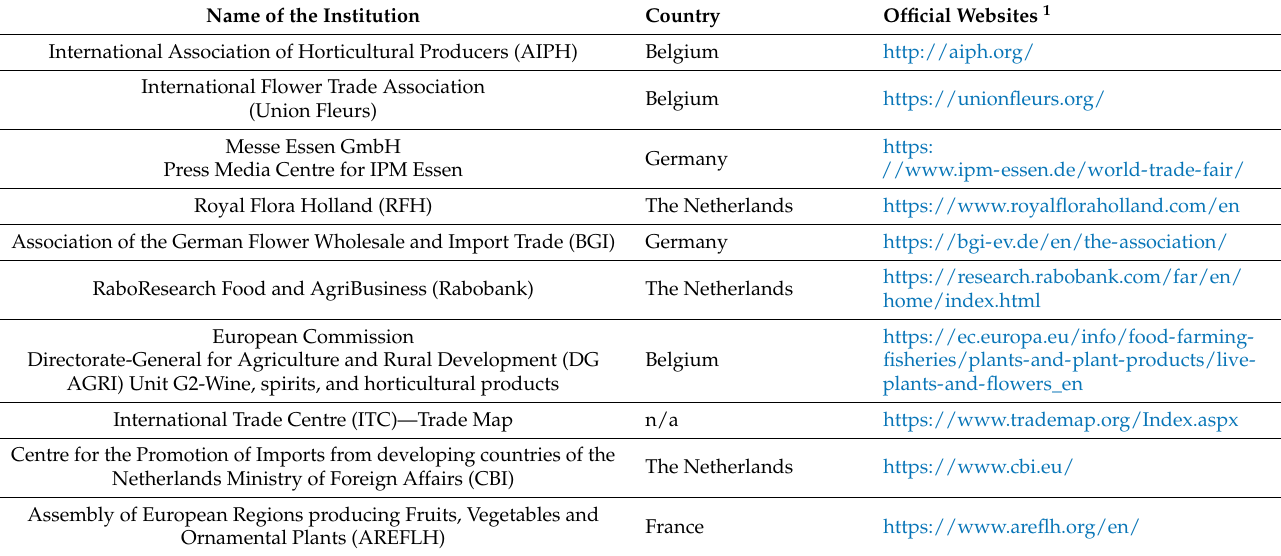
Table 2. Major institutional sources in the European ornamental sector.